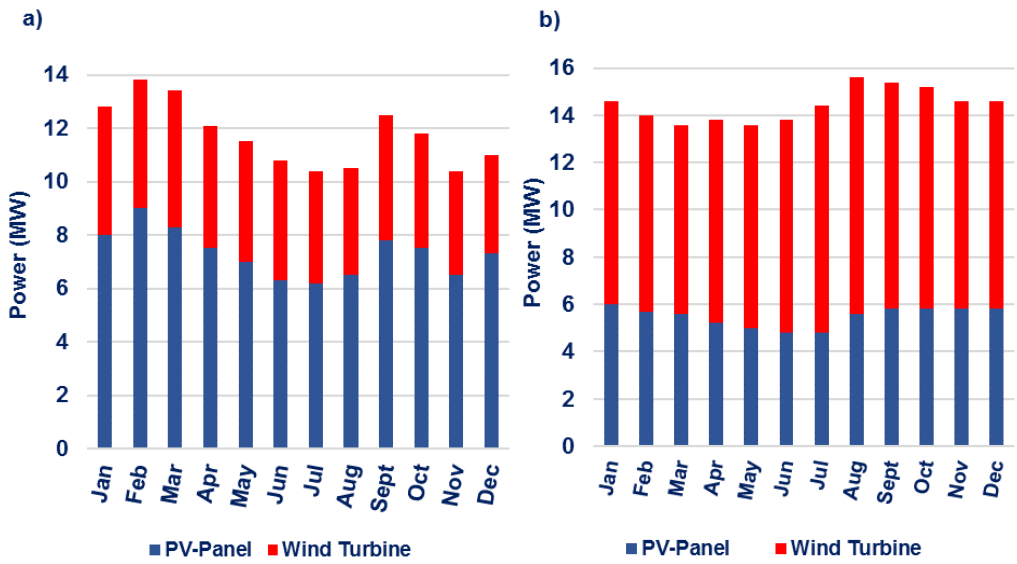
Processes 2016 , 4 , 54